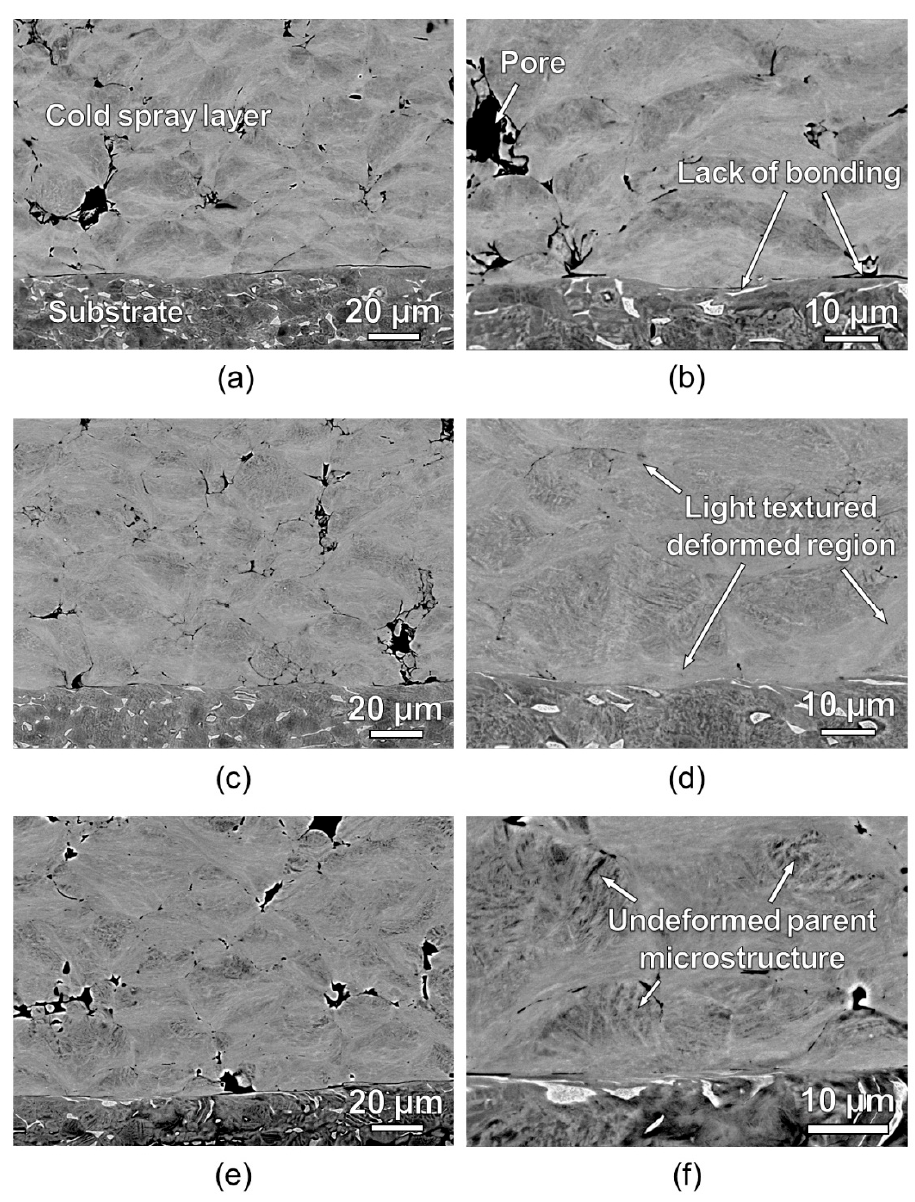
Figure 11. Backscattered SEM images of cold sprayed coupons in ( a , b ) as-sprayed; ( c , d ) deep cold rolled; ( e , f ) controlled hammer peened condition.